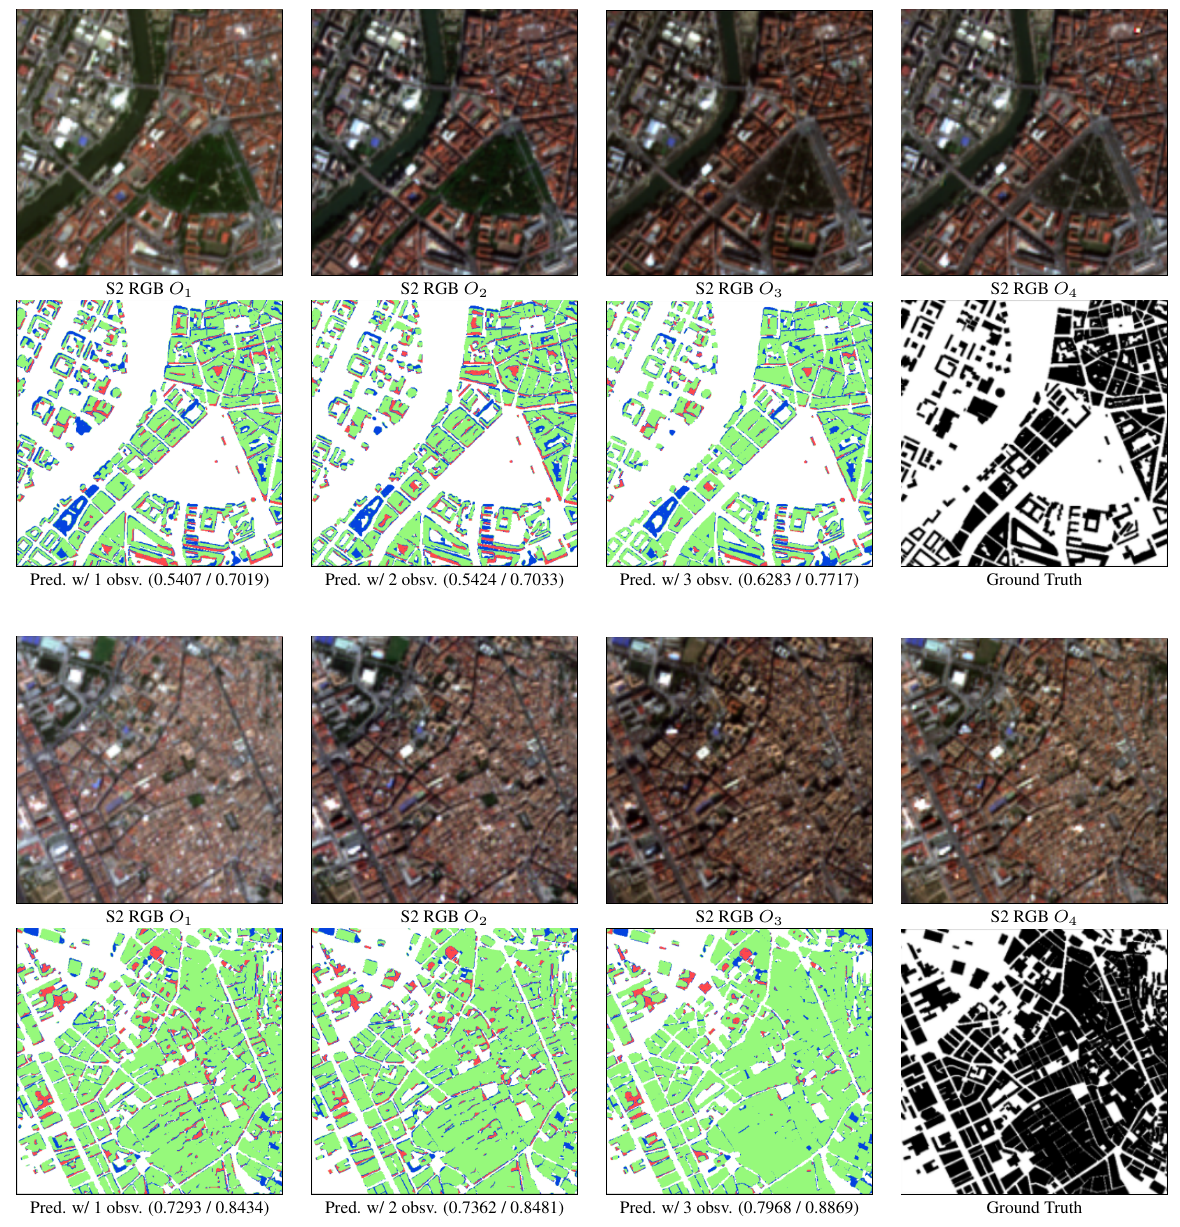
Figure 5. Visual comparison of the results obtained for the building footprint extraction task. Predictions are performed for the 4th observation ( O 4 ) when trained using 1, 2, and 3 observations for two zones randomly taken from the test set. True Positives (TP) are presented in green, False Positives (FP) in blue, False Positives (FP) in red, and True Negatives (TN) in white. Moreover, the IoU and F-score metrics have been